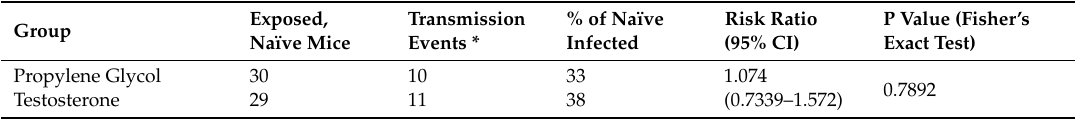
Table 4. Transmission of SNV by deer mice with/without